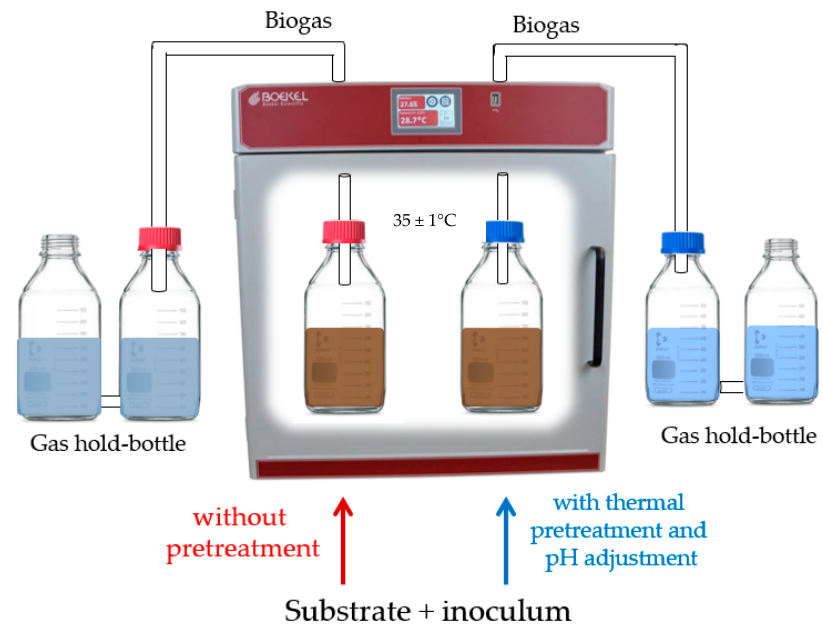
Figure 1. Laboratory set-up.